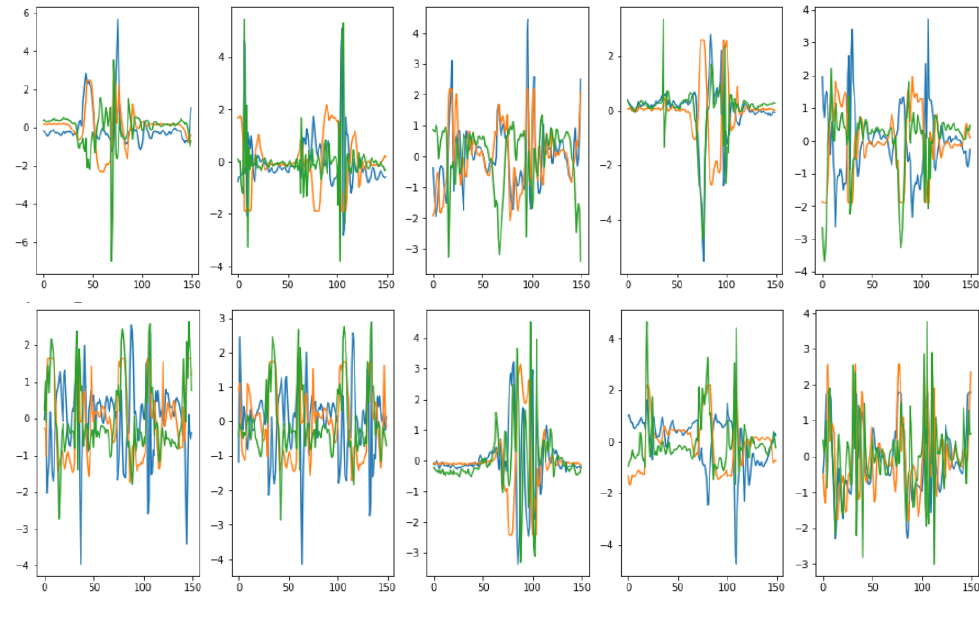
Figure 9. Real data for jumping column.